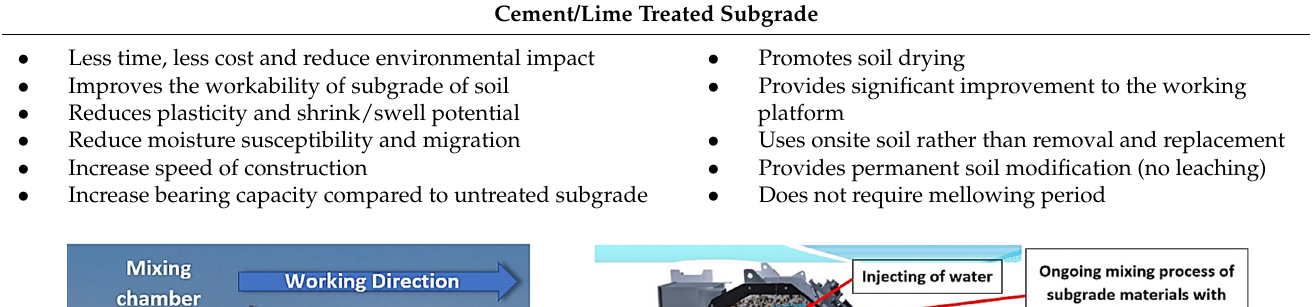
Figure 2. The application process of binder agent in real-life road construction. Table 1. Merits of in situ stabilised subgrade and demerits of subgrade removal and replacement [15].